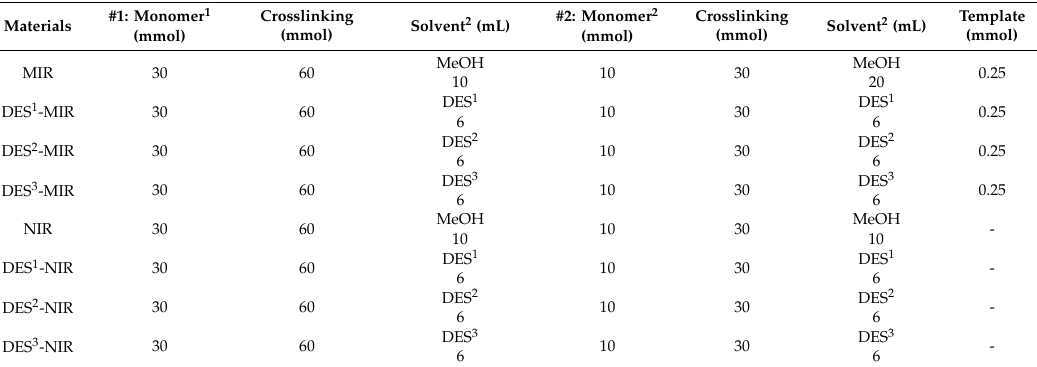
Table 2. Synthesis scheme of